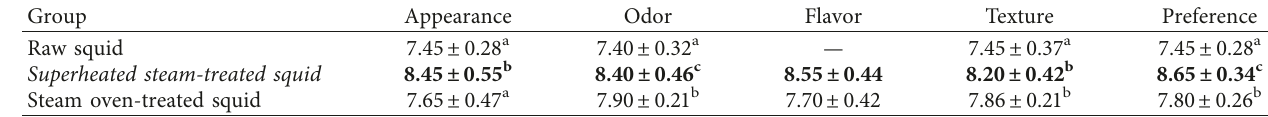
Table 4: Sensory evaluation of raw, superheated steam-treated, and steam oven-treated squid.